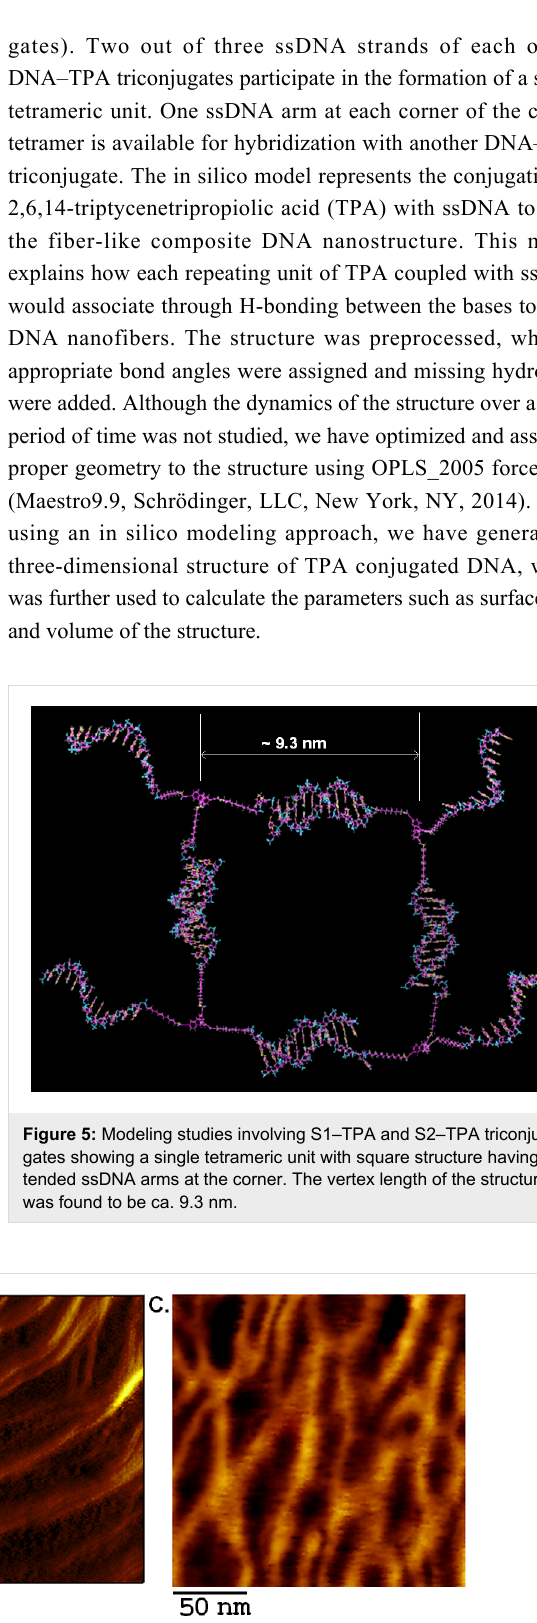
size distribution after the self-assembly of DNA–TPA triconju- gates is broad with a high polydispersity index (PDI) whereas the PDI decreases in the presence of Zn PpIX. A narrow size distribution for the coassembly of DNA–TPA triconjugates with Zn PpIX correlates well with the appearance of higher-ordered structures in the native PAGE.